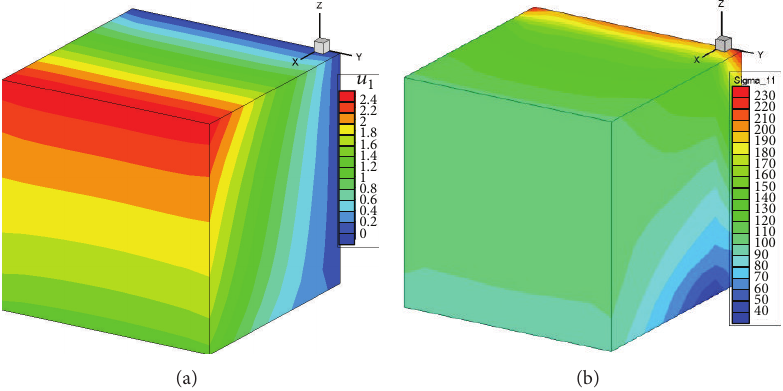
Figure 11: Contour plots of (a) displacement 𝑢 1 and (b) stress 𝜎 11 of the cube.